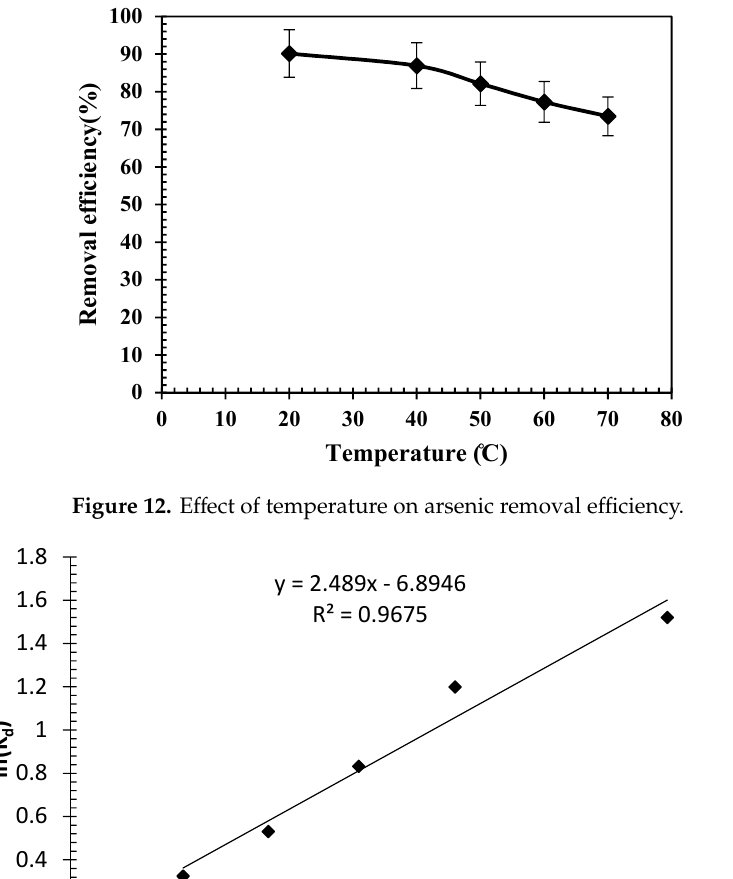
Figure 13. The van’t Hoff plot for adsorption of arsenic onto iron nanoparticles.